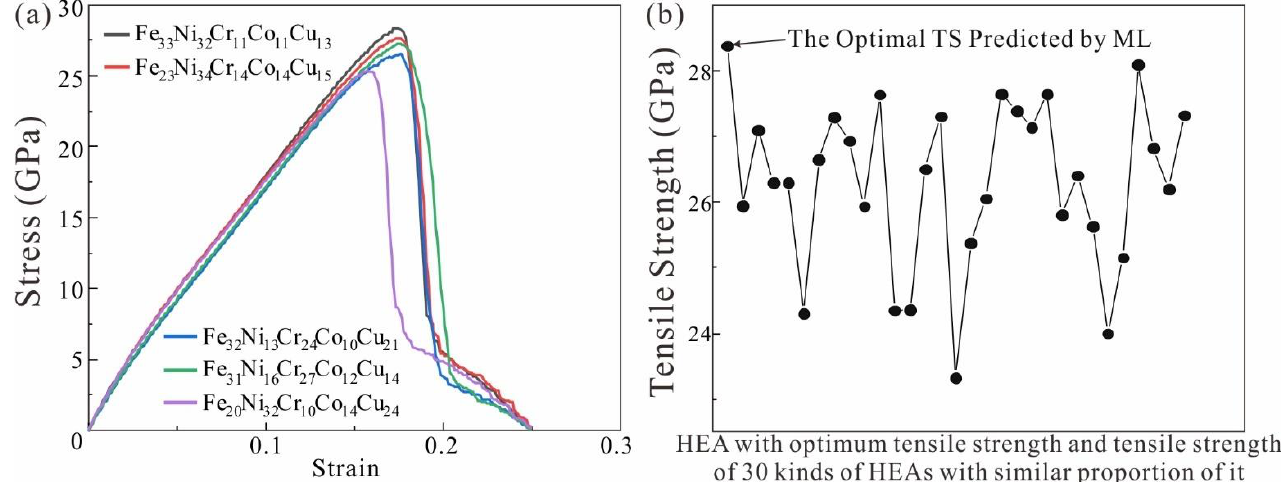
Figure 4. ( a ) Tensile stress-strain curves of Fe 33 Ni 32 Cr 11 Co 11 Cu 13 HEA and HEAs with similar component proportions; ( b ) Comparison of optimal mechanical properties of HEA and HEAs with other component ratios.